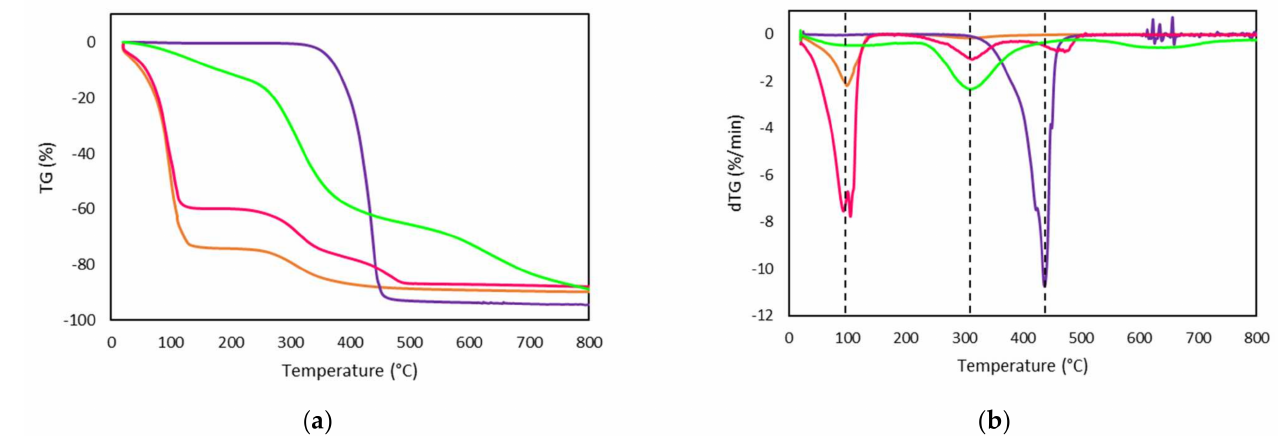
Figure 9. ( a ) TGA thermogram; ( b ) dTGA thermogram obtained from TG curves of ( — ) Dry GE, ( — ) GE, ( — ) GE/15IL and ( — )